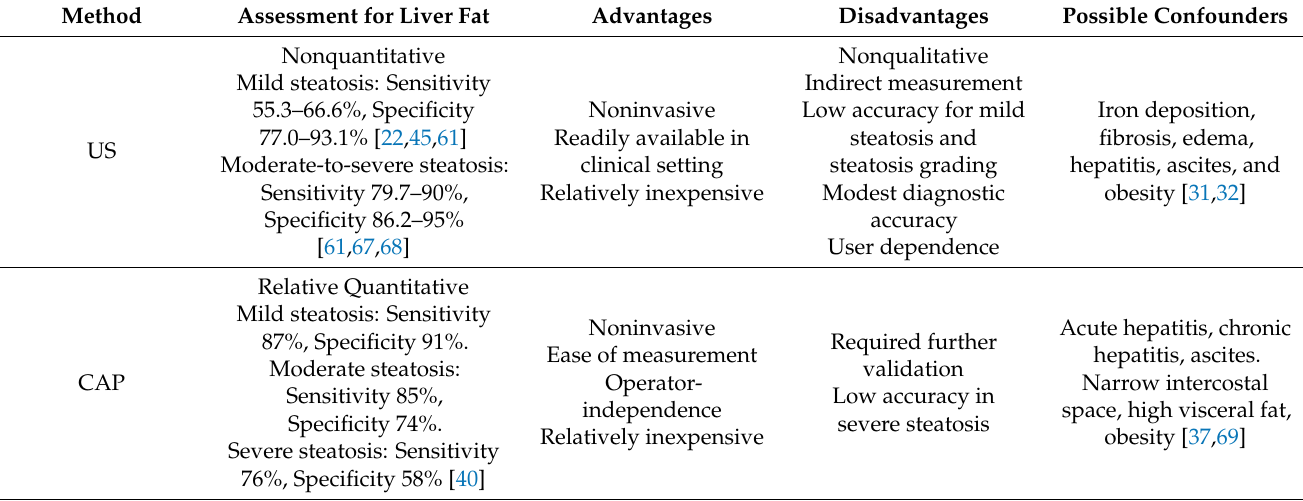
Table 1. Imaging techniques for liver fat